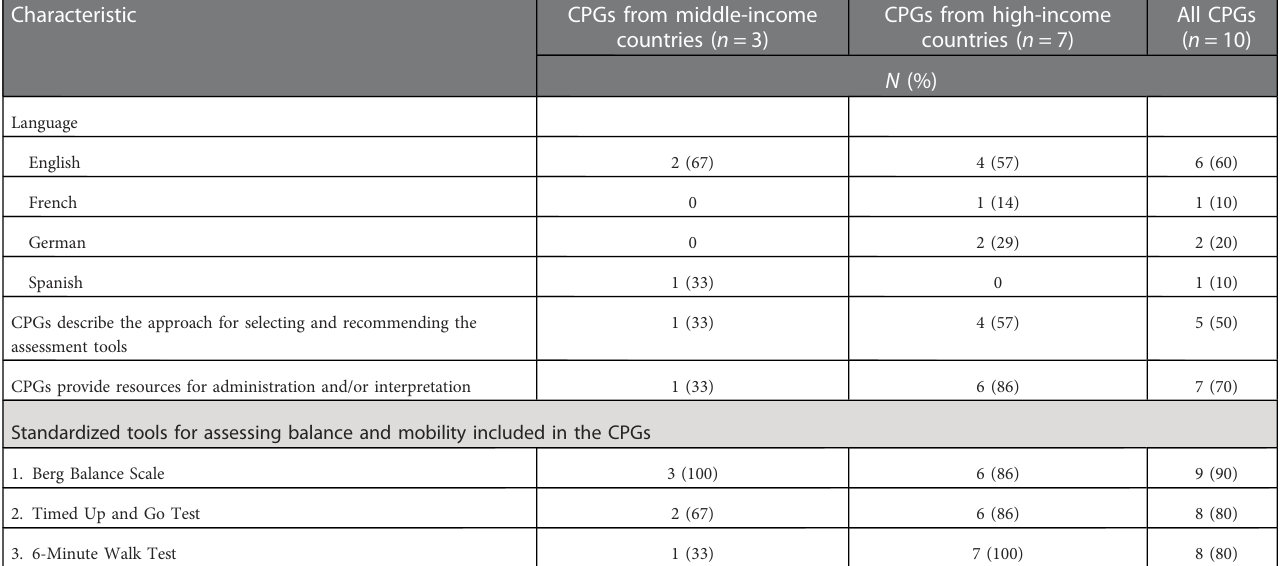
TABLE 4 Characteristics of guidelines that include balance and/or mobility assessment tools analyzed by country income